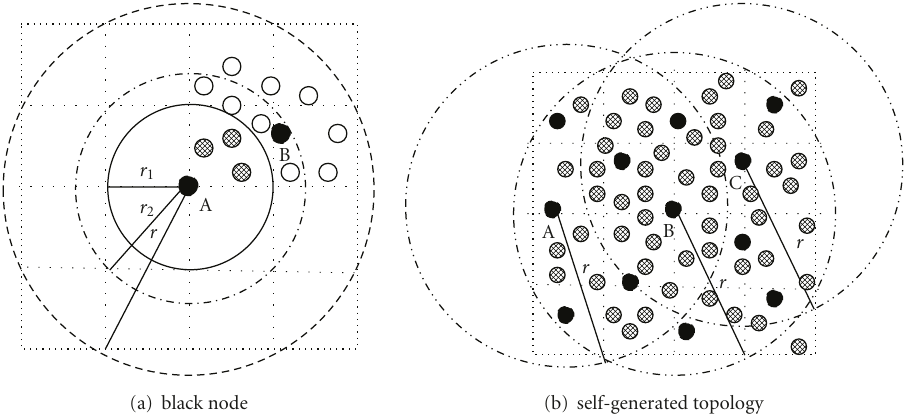
Figure 1: Tricolor-Based Topology Discovery: Black nodes are filled in the black, and the grey nodes are shaded by the gird instead of being filled in grey for obviously